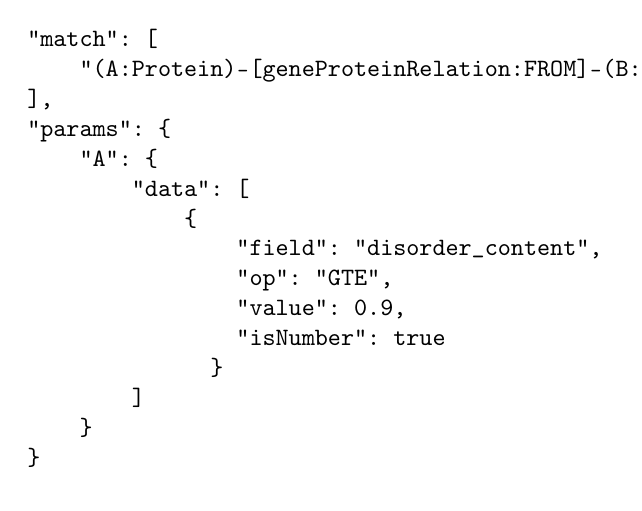
Figure 5. Example of an internal BioGraph query in JSON format. The query fetches all genes and related proteins where the protein disorder content is 0.9 or